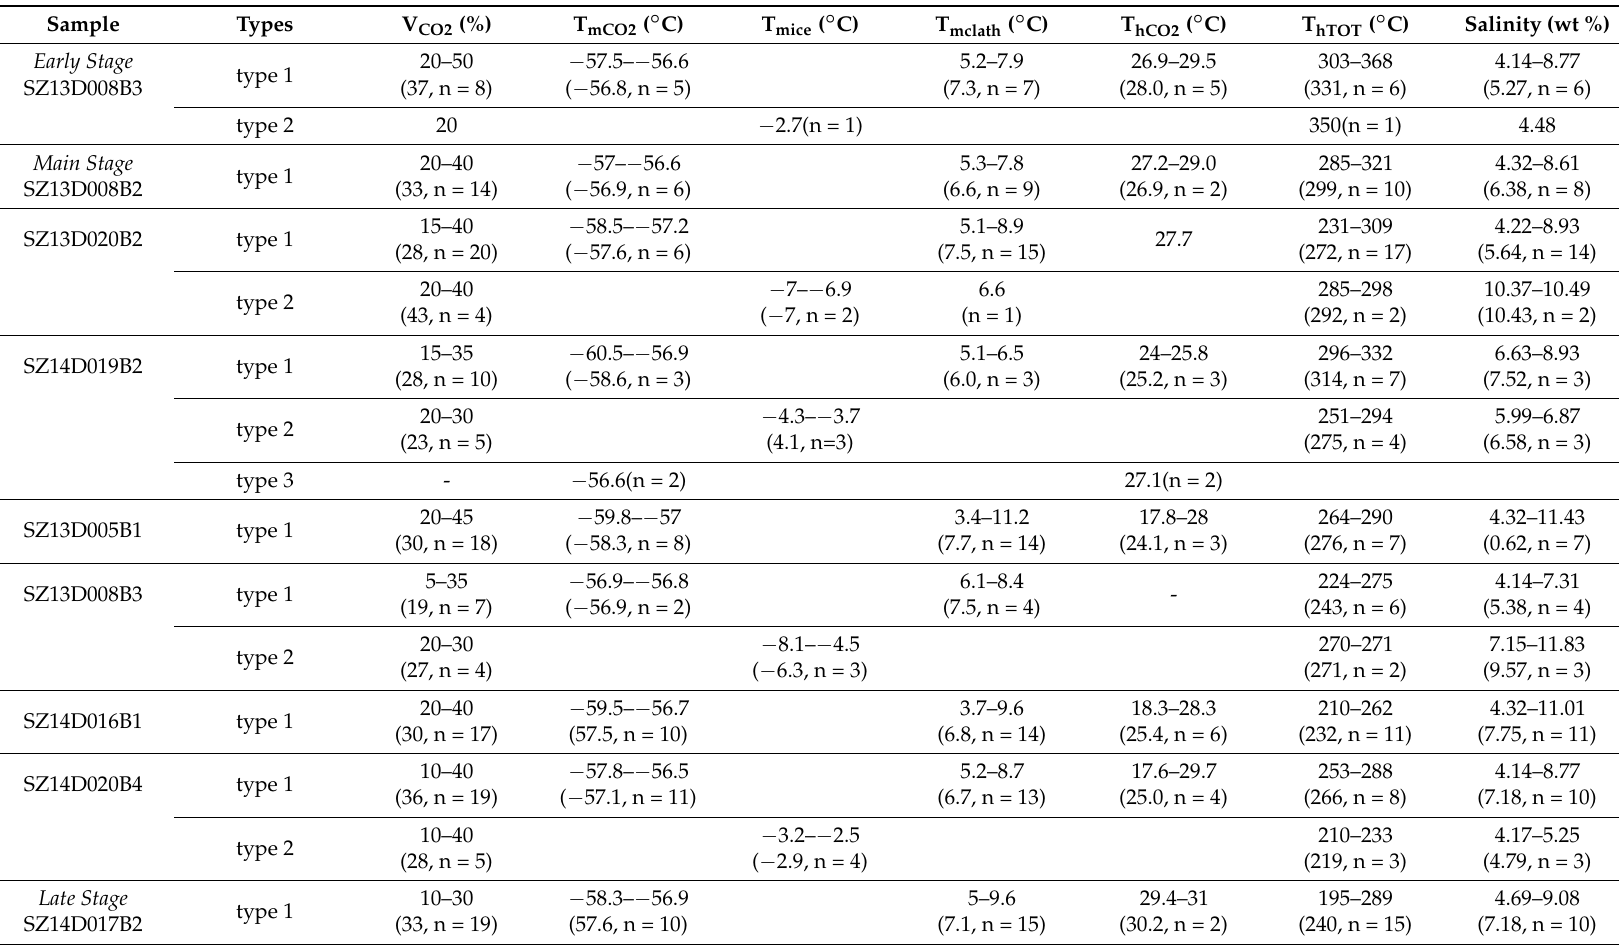
Table 2. The results of fluid inclusions